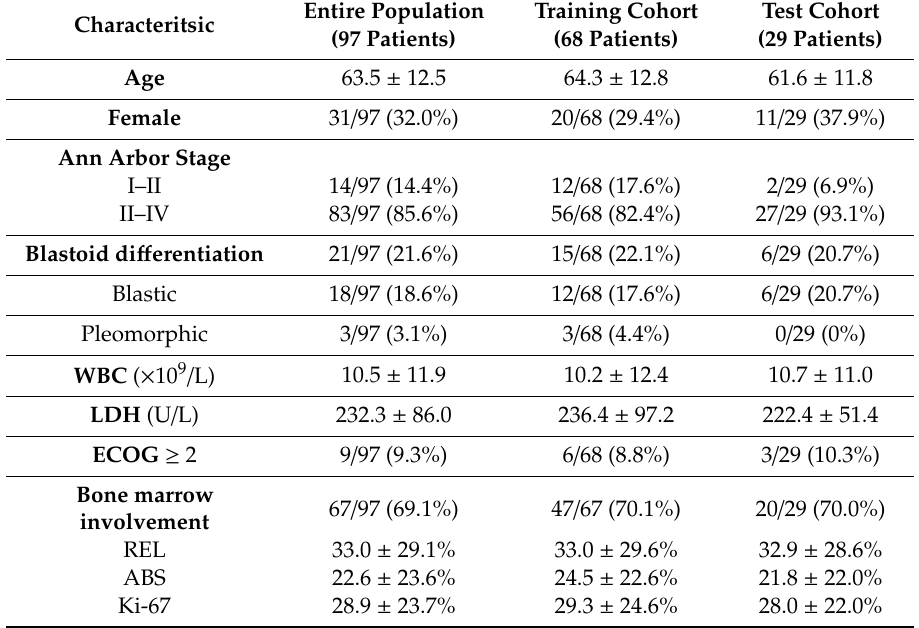
Table 1. Baseline demographic, clinical, laboratory and biological data of the entire cohort and the training and test cohorts for involved vs. uninvolved bone marrow.